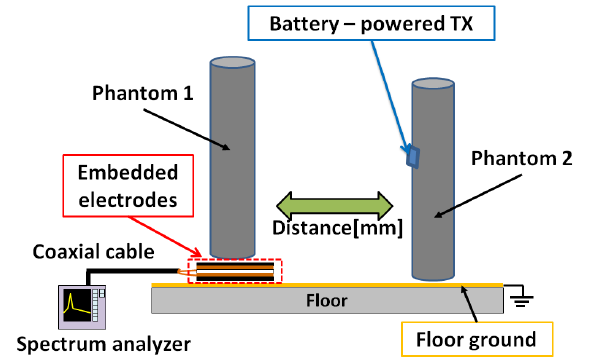
Figure 7. Schematic of experimental system.